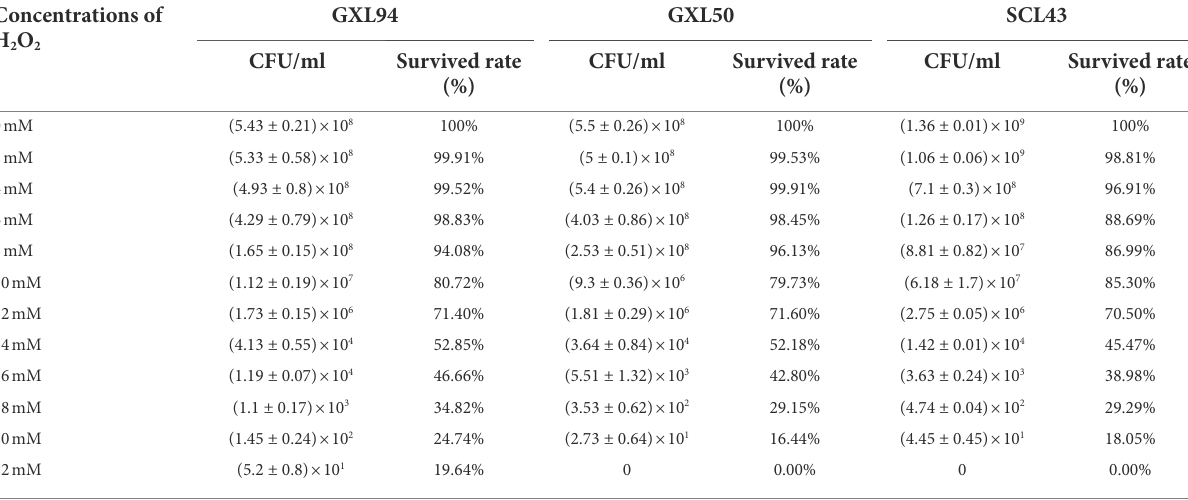
TABLE 2 Survival rates (%) of LAB in different concentrations of hydrogen peroxide. Concentrations of H 2 O